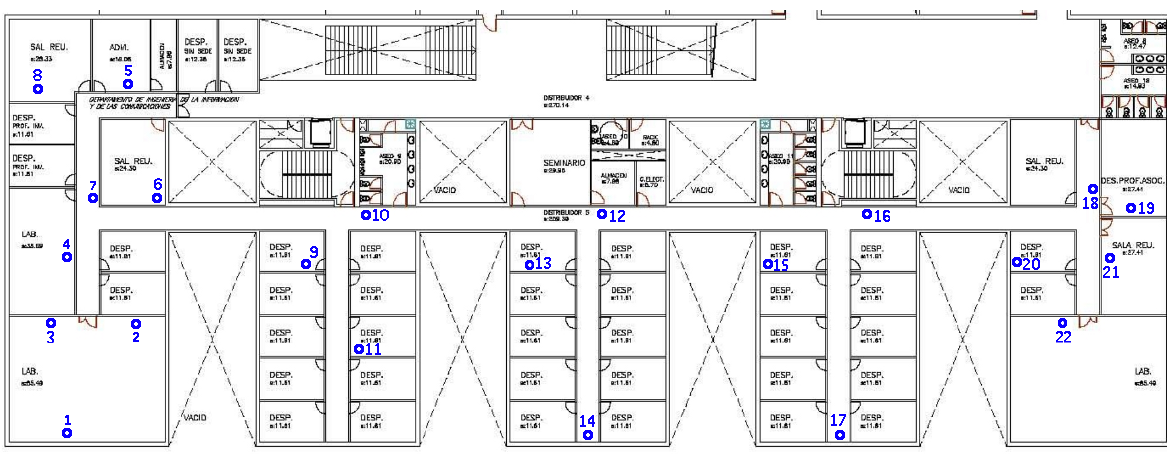
Figure 6. The environment and the deployment of the